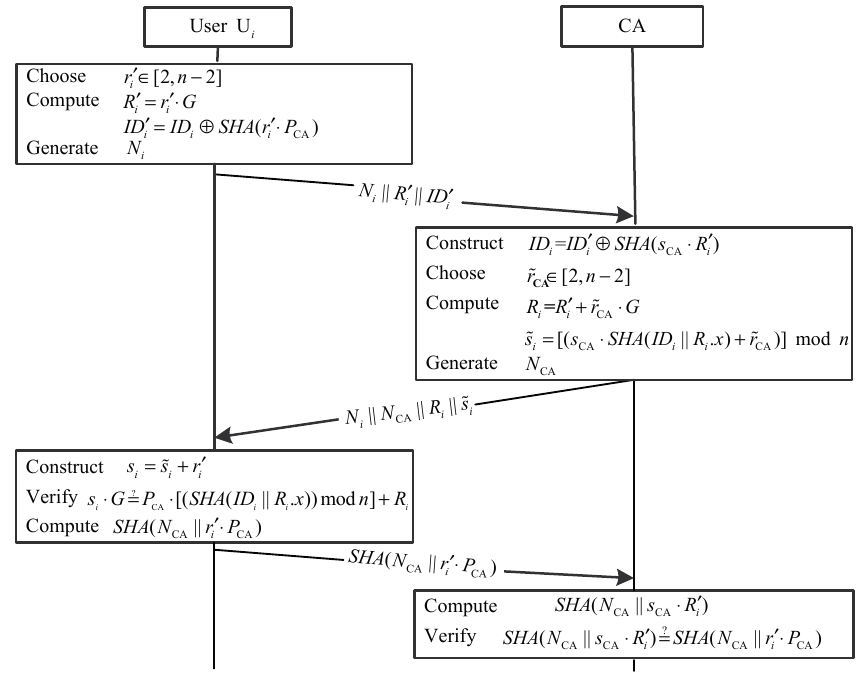
Figure 2. The user registration